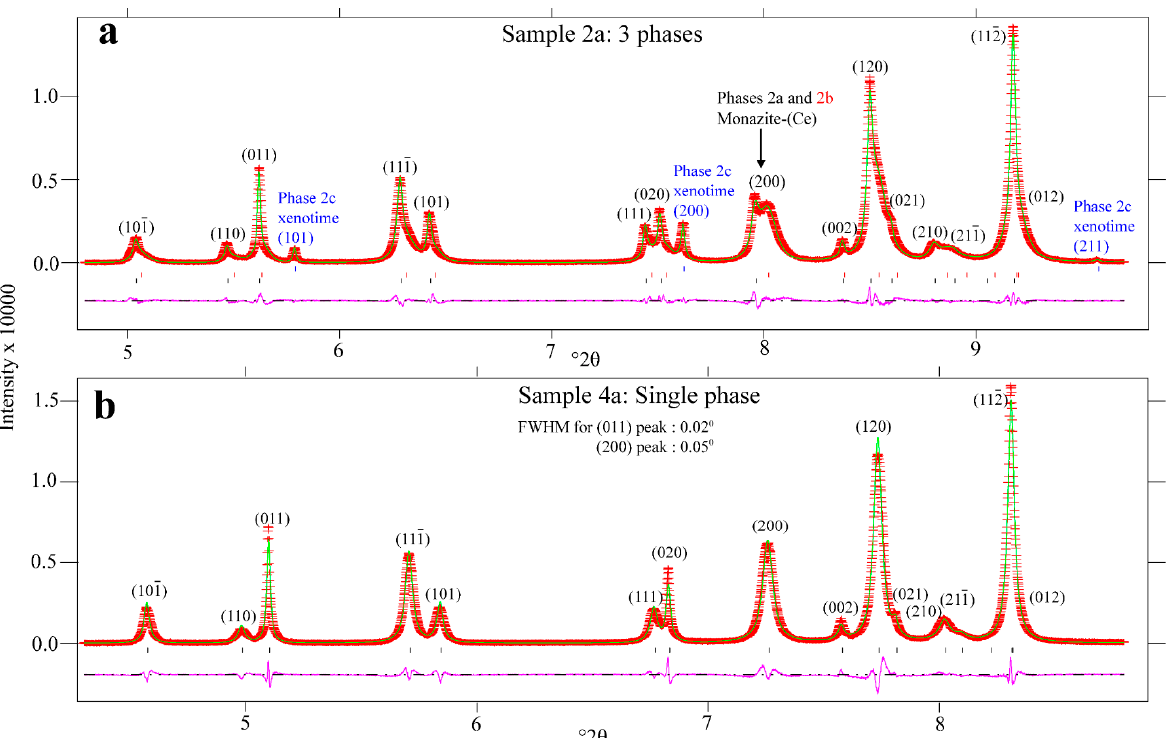
Figure 5. Expanded parts of the synchrotron HRPXRD traces. ( a ) Sample 2a contains three different phases: a xenotime- (Y) (3.5 wt. %) and two monazite-(Ce) phases where phase 2a is 30.5 wt. % and phase 2b is 66.0 wt. %. Three peaks from xenotime-(Y) are labelled. The split 200 reflection corresponds to phases 2a and 2b. ( b ) Sample 4a is a single monazite- (Sm) phase.